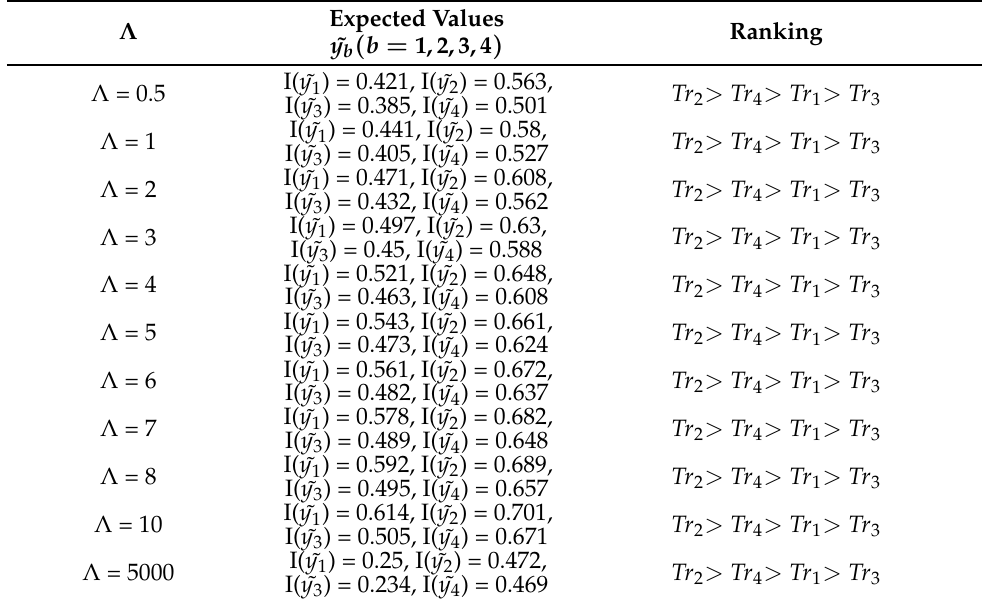
Table 5. The impact of the parameters Λ on the ranking outcome of example 1 for ITFPGWA operator.